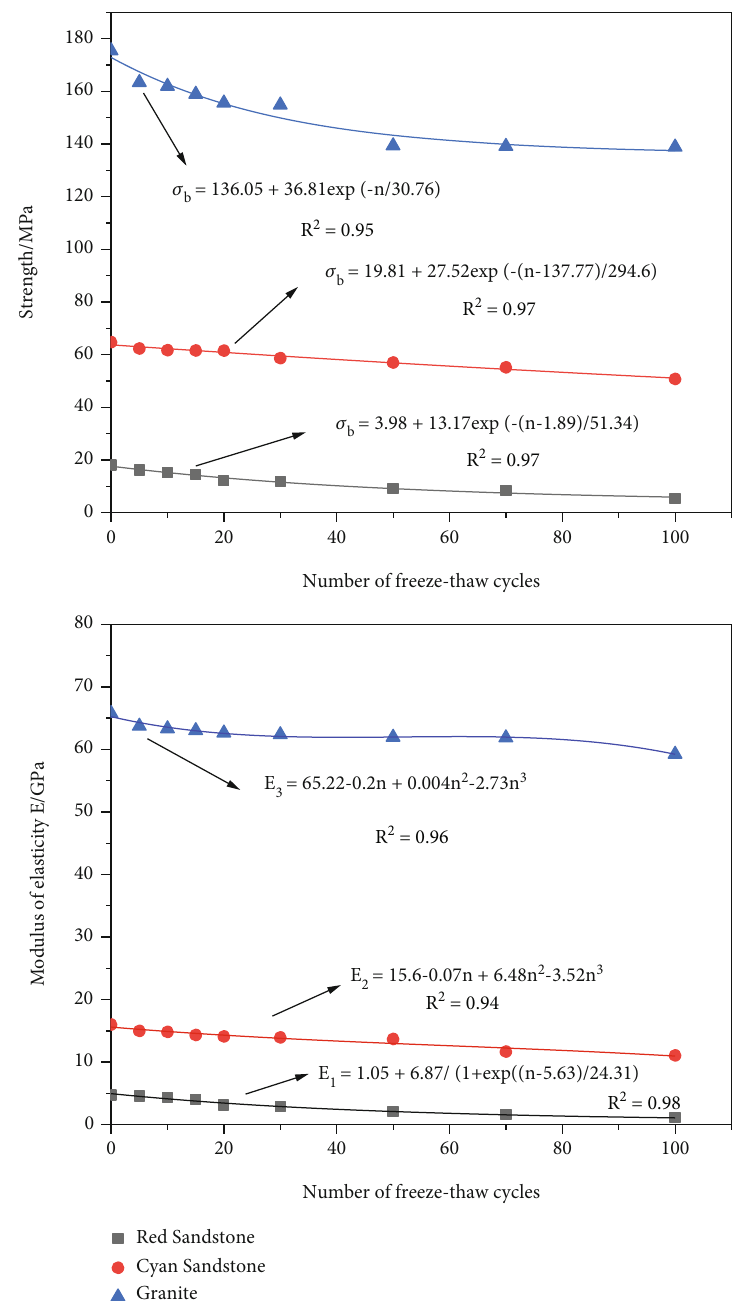
Figure 8: Curve of the e ff ect of freeze-thaw cycles on the three types of crushed-rocks. Table 2: Relationship between freeze-thaw coe ffi cients and the number of freeze-thaw cycles for three types of crushed-rocks.